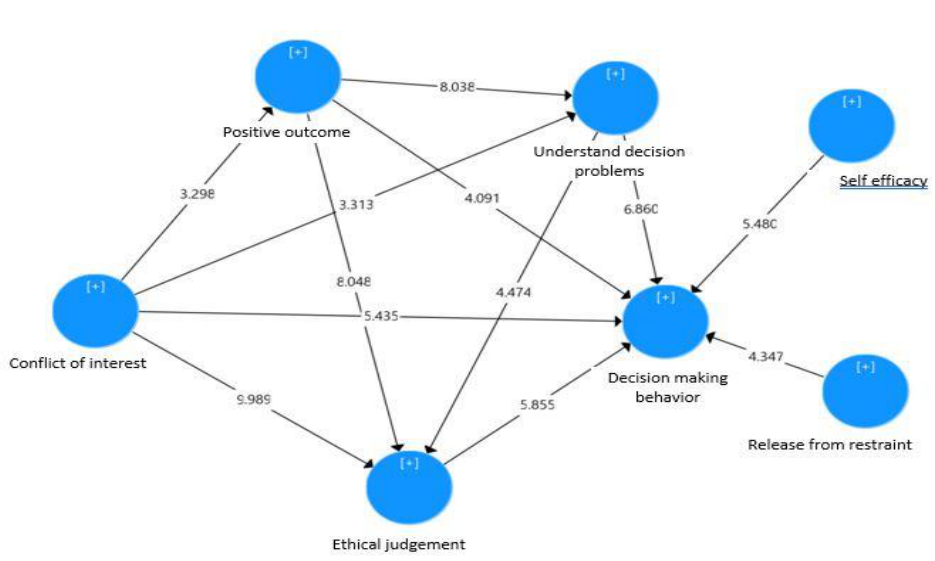
Model 1. Graphic model of research (showing path coefficients and coefficient of determination